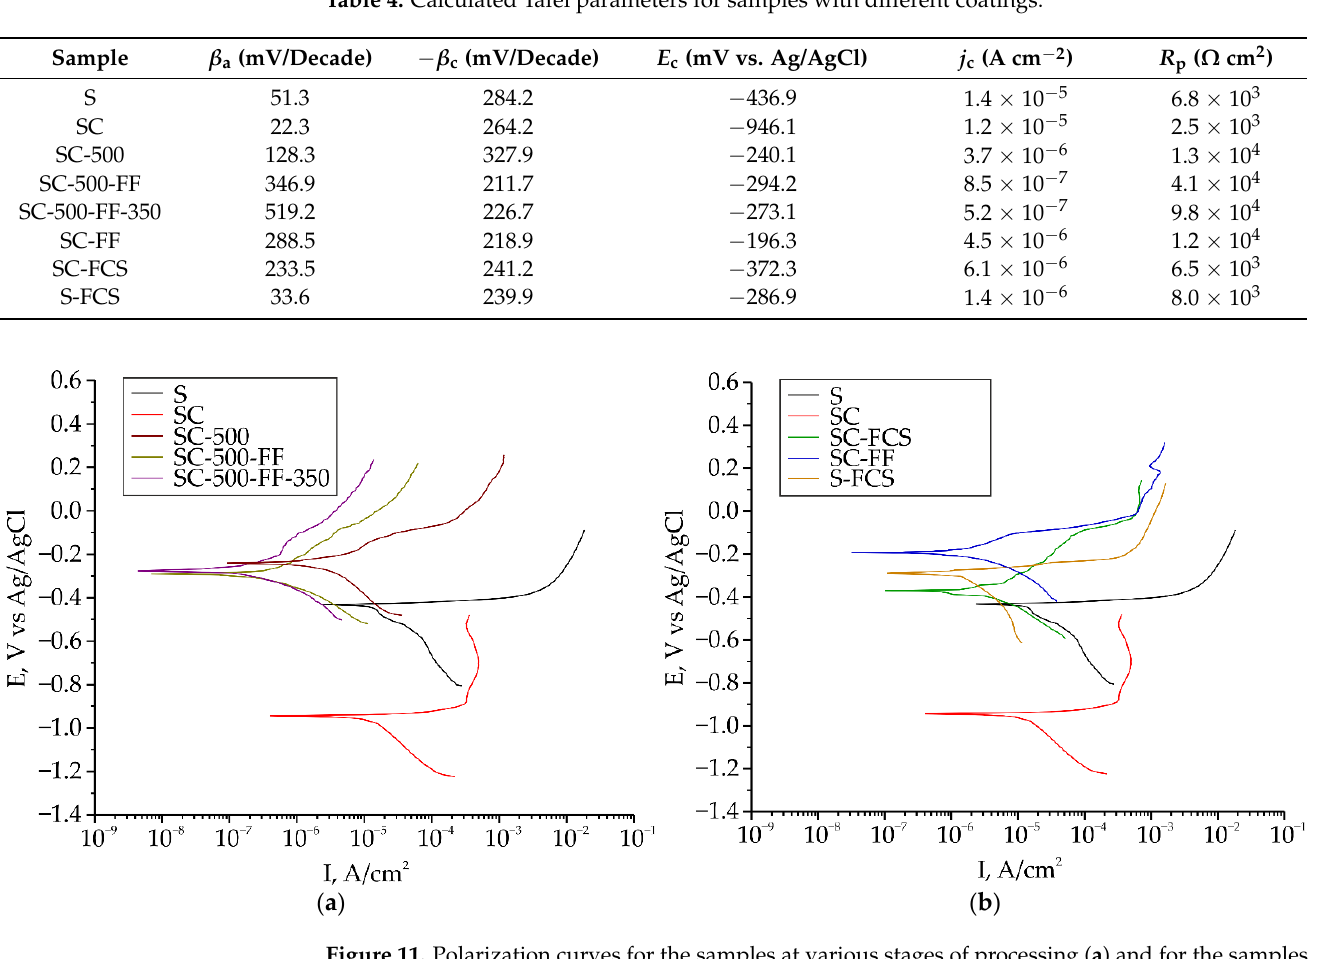
Figure 11. Polarization curves for the samples at various stages of processing ( a ) and for the samples at different types of SPTFE deposition ( b ). Table 4. Calculated Tafel parameters for samples with different coatings.